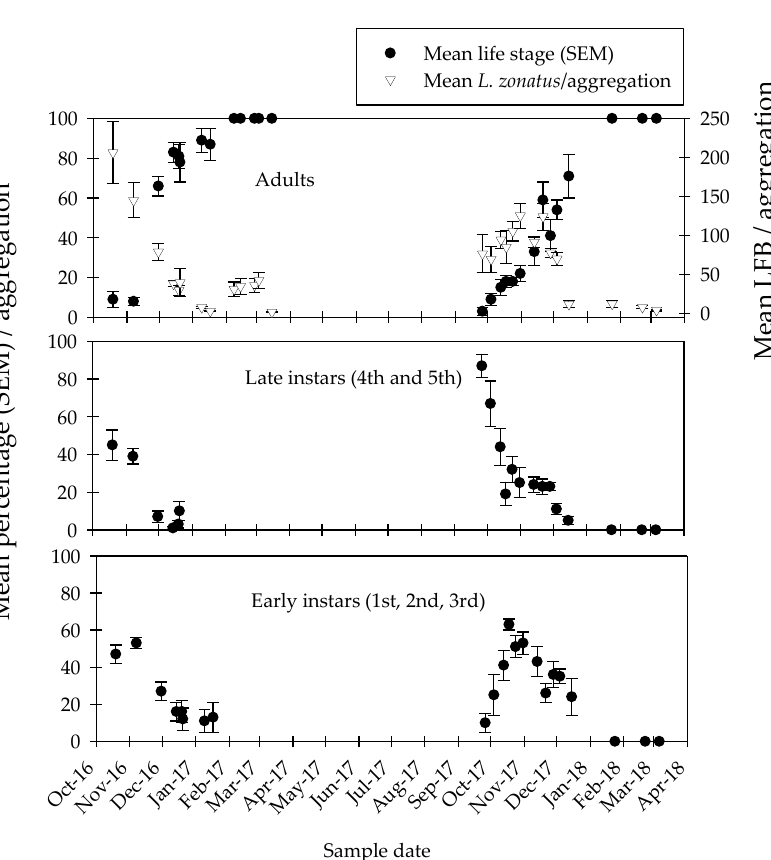
Figure 3. Mean number of individuals and percentage of early, late, and adult L. zonatus per aggregation sampled. Aggregations collected on pomegranate (19 Oct 2016 to 17 Jan 2017, and 26 Sept 2017 to 15 Dec 2017). Aggregations collected on Cypress (8 Feb 2017 to 15 Mar 2017, and 24 Jan 2018 to 6 Mar 2018).